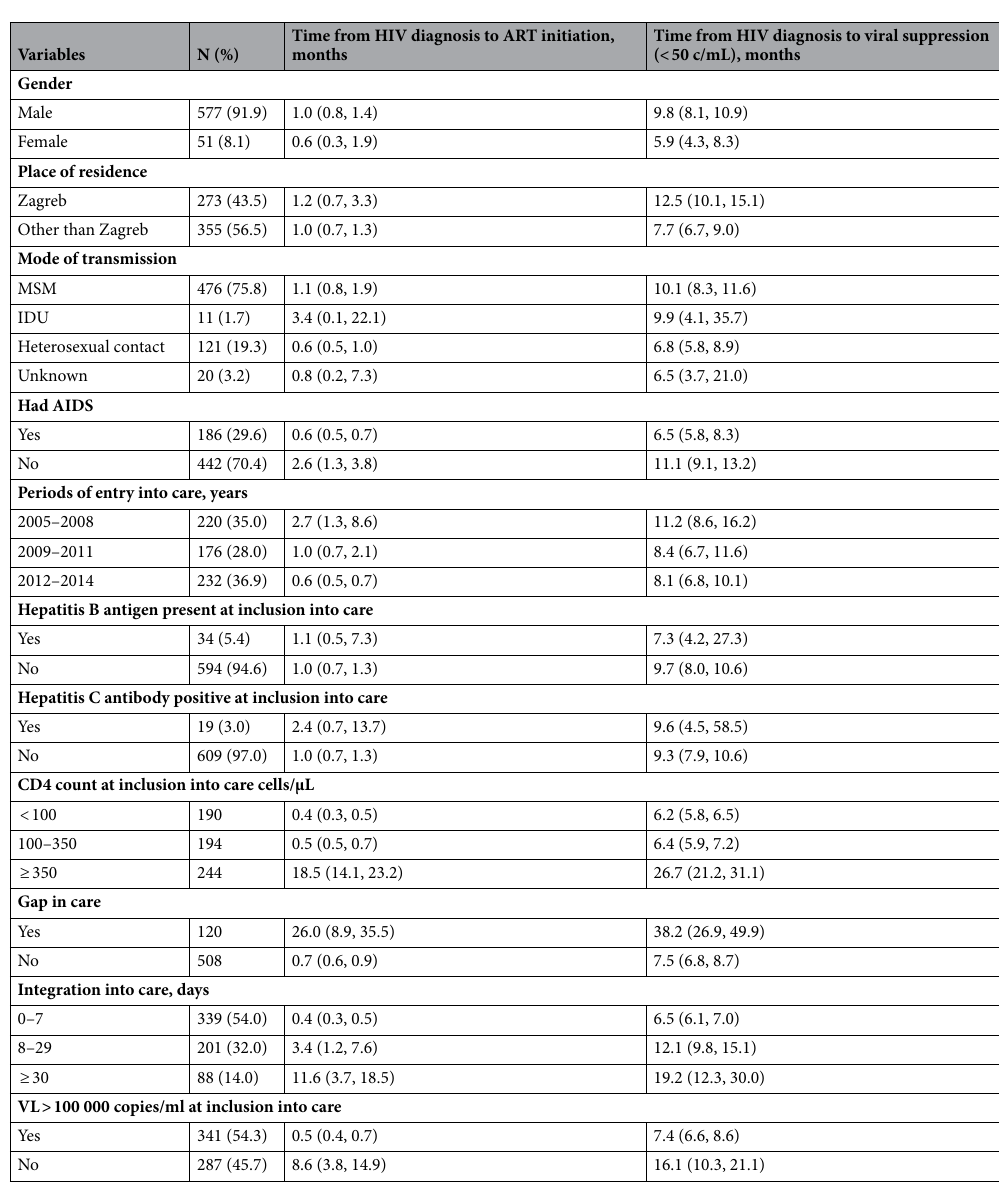
Table 2. Time from HIV diagnosis to antiretroviral treatment initiation and to viral suppression (< 50 copies/ml) in 628 individuals entering care in Croatia from 2005 to 2014. Values are frequencies, percentages, medians and 95% confidence intervals (CI). Medians and 95% CI are derived from the product-limit (Kaplan–Meier) estimates. MSM men who have sex with men, IDU injection drug users, VL, NRTI, nucleoside analogues reverse transcriptase inhibitors, NNRTI nonnucleoside reverse transcriptase inhibitors, II integrase inhibitors, PI protease inhibitors, VL viral